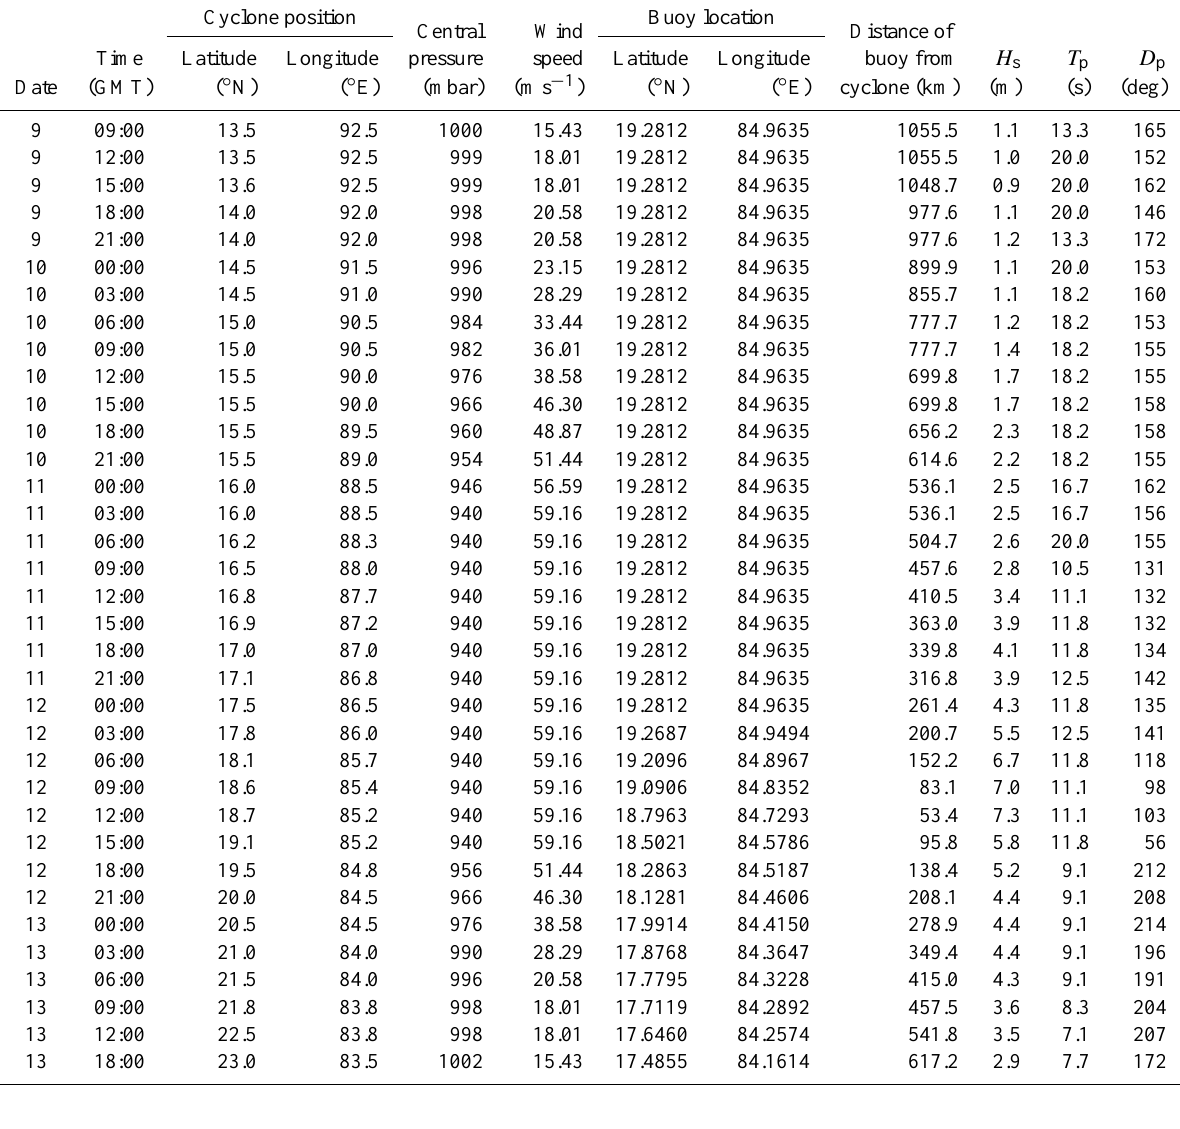
Table 1. Cyclone position, wind speed, buoy location and wave parameters during 9–13 October